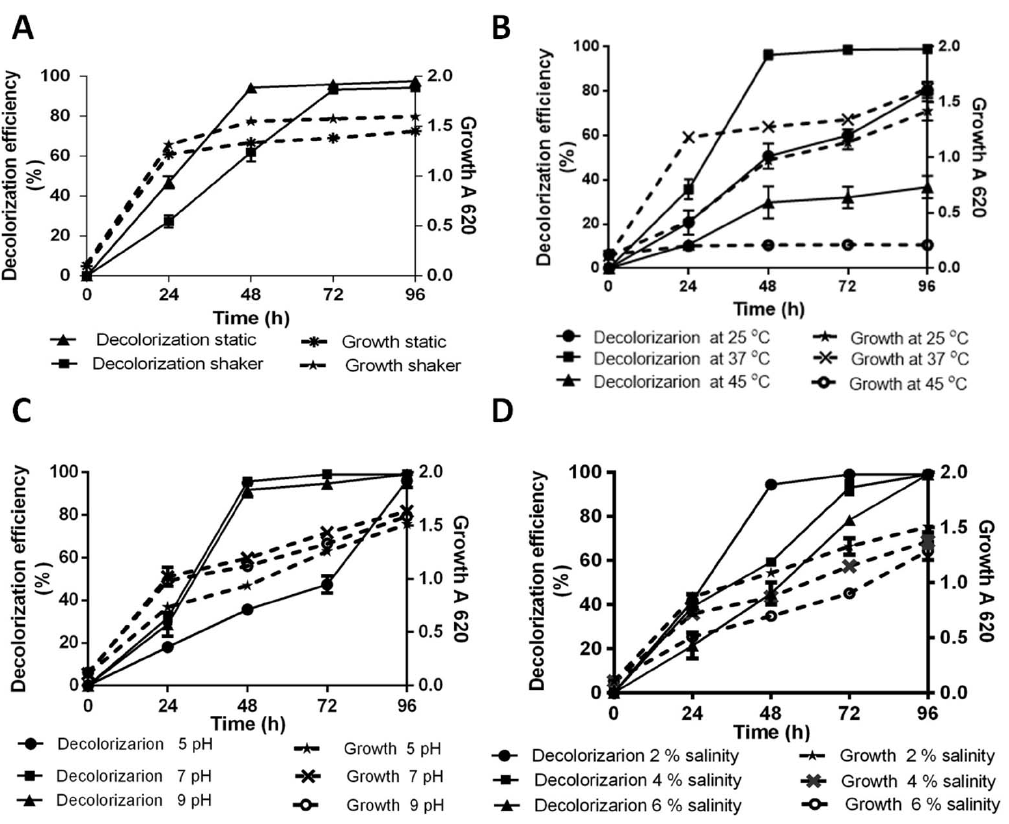
Fig. 2. Percentage decolorization of 100 µg/ml AR with 100 µg/ml Cr(VI) and growth kinetic by SK1; static and shaken (A), variable temperature 25°C, 37°C and 45 ºC (B), pH 5, 7 and 9 (C) and Salinity 2%, 4%, 6%